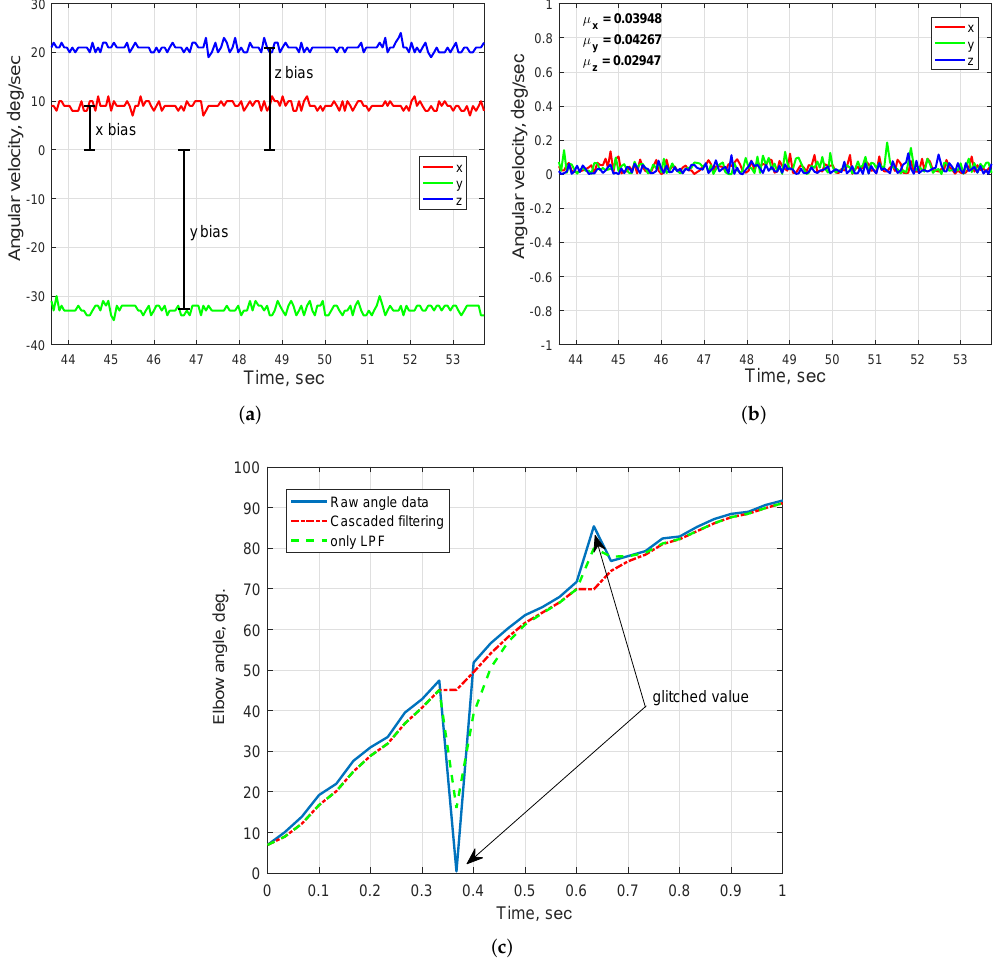
Figure 6. System sensor calibration: UM7-LT IMU gyroscope raw ( a ) and calibrated ( b ) measurements; ( c ) potentiometer data